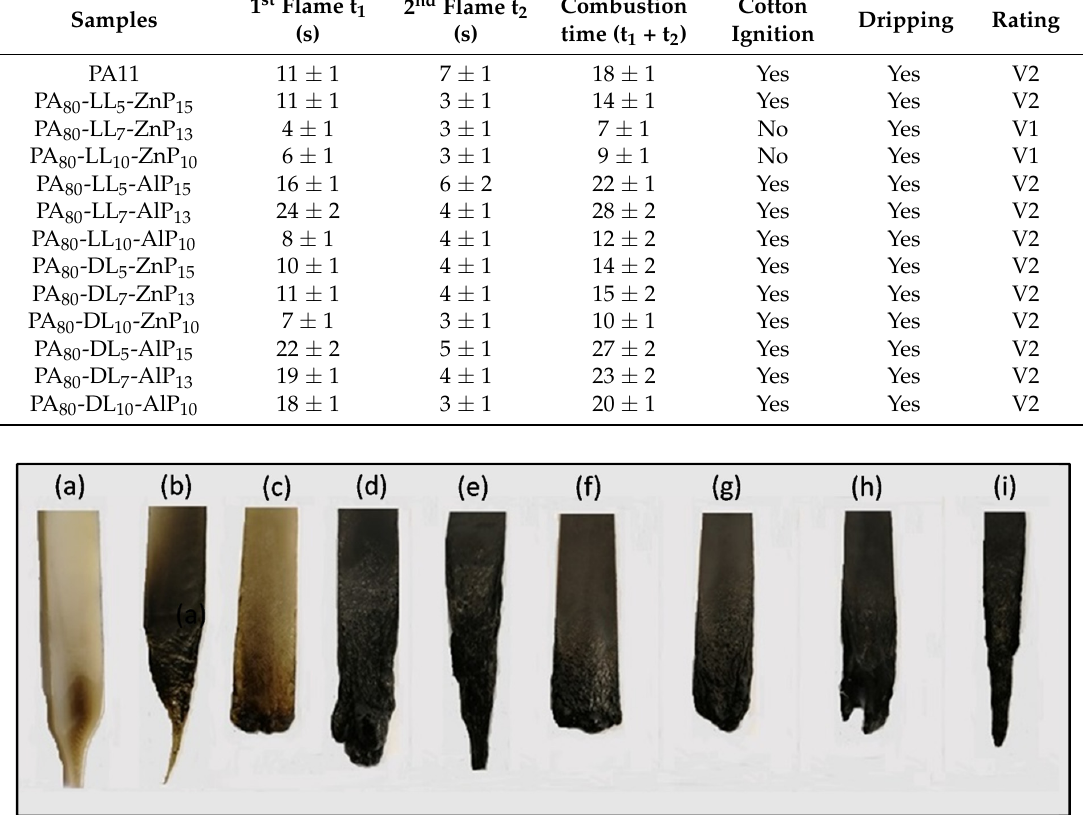
Table 3. UL94 vertical flame spread test data for polyamide 11 (PA11) and its blends. Samples